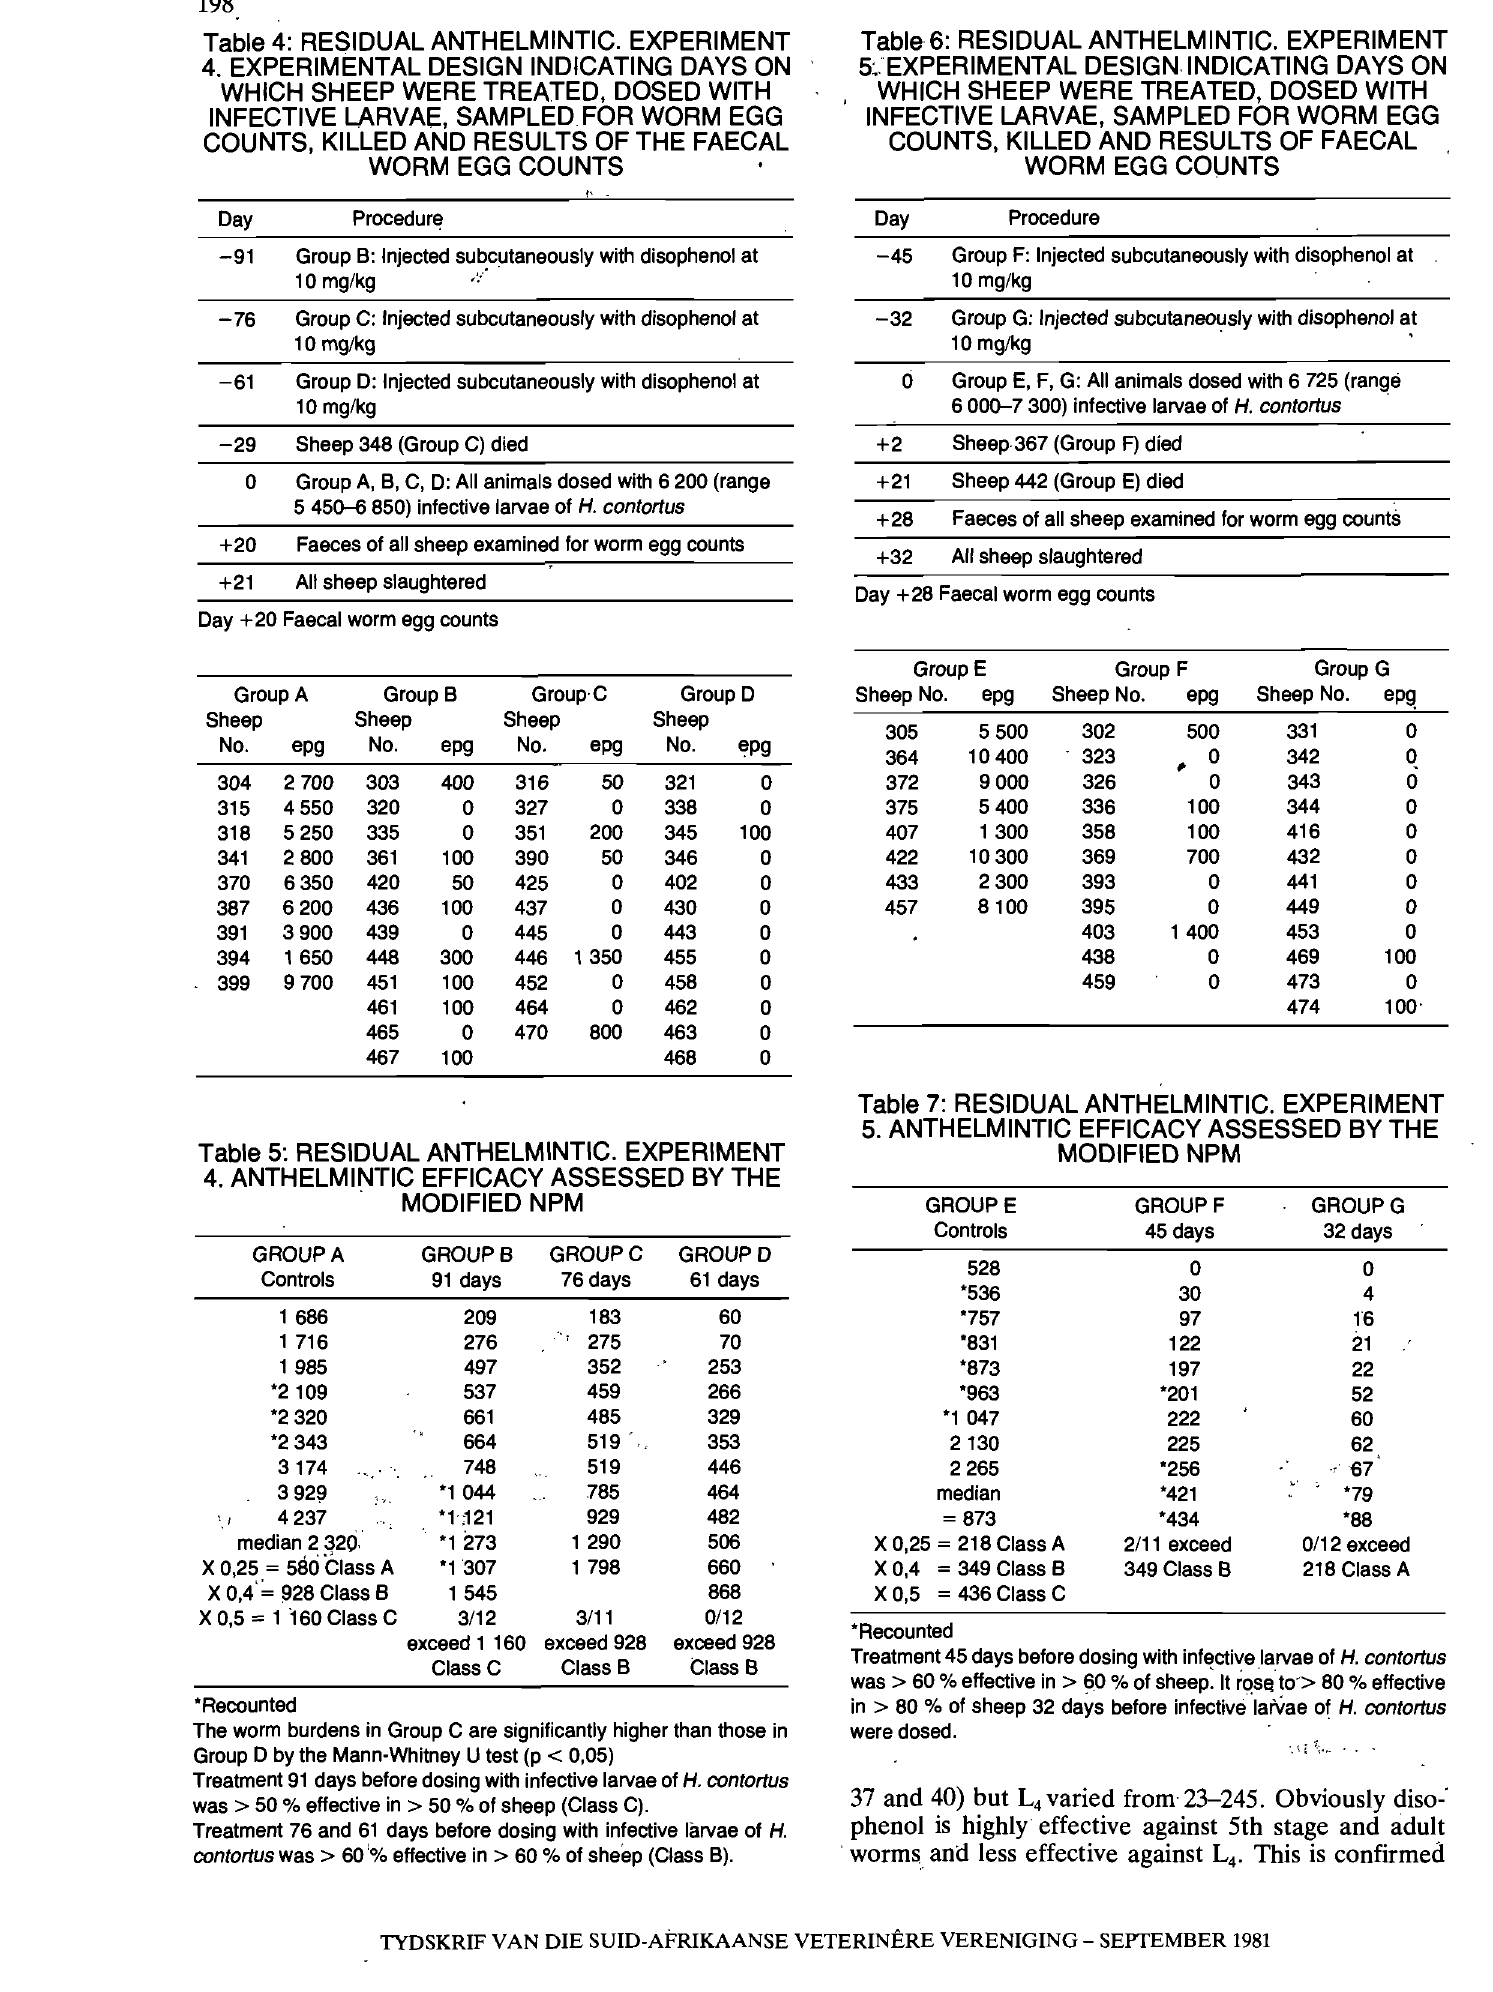
Table 6: RESIDUAL ANTHELMINTIC. EXPERIMENT